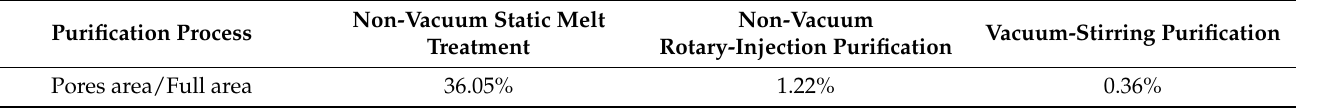
Figure 2. Pore size and content of Al-6Mg alloy melt solidified under reduced pressure after melt purification: ( a ) non-vacuum static melt treatment, ( b ) non-vacuum rotary-injection purification, ( c ) vacuum-stirring purification.